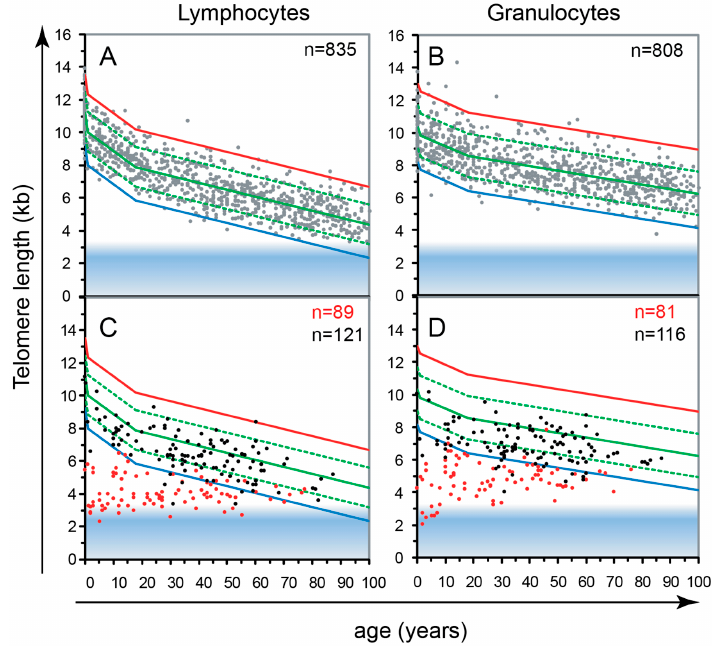
Figure 2. ( A , B ) Telomeres in human lymphocytes and granulocytes from peripheral blood shorten with age [15]. Fluorescence in situ hybridization followed by flow cytometry (Flow FISH) results from over 800 healthy individuals were used to calculate the distribution of telomere length at any given age (percentiles in population: solid green 50th; red 1st, blue 99th). Note the marked variation on average, cell specific telomere length at any given age. ( C , D ) The critical role of telomerase is illustrated by the telomere length in cells from patients that are haplo ‐ insufficient for telomerase genes (red dots in C and D) compared to their unaffected siblings (black dots in C and D). The blue zone at the bottom of the graphs represents the area where telomeres are expected to be fully “uncapped” with less than 1 kb of TTAGGG repeats per chromosome end. Reproduced with permission from [12].